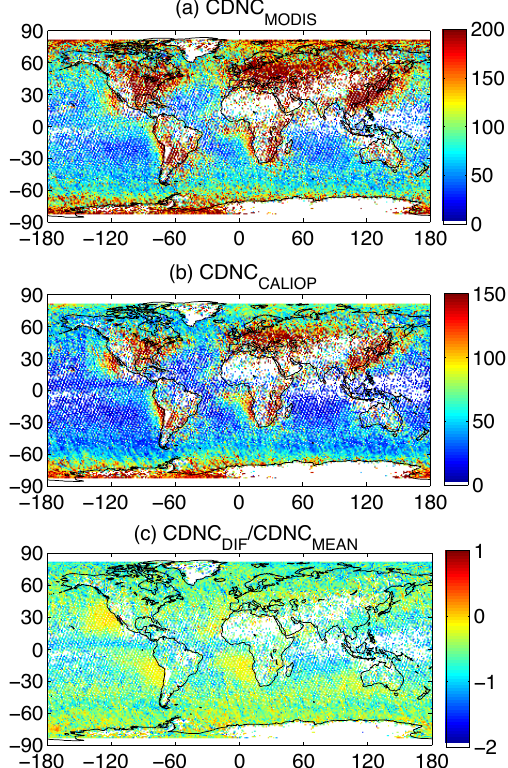
Figure 1. Geographical distributions of CDNC (cm − 3 ) derived from MODIS (a) , CALIOP (b) and their relative differences (c) . The MODIS 3.7µm effective radius is used for the